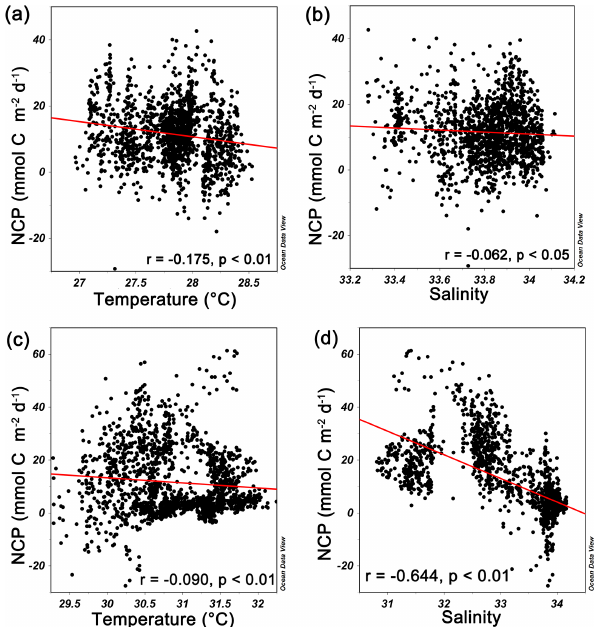
Figure 9. Correlation analysis between underway NCP and physical parameters (temperature and salinity) in October 2014 (a, b) and June 2015 (c, d) .